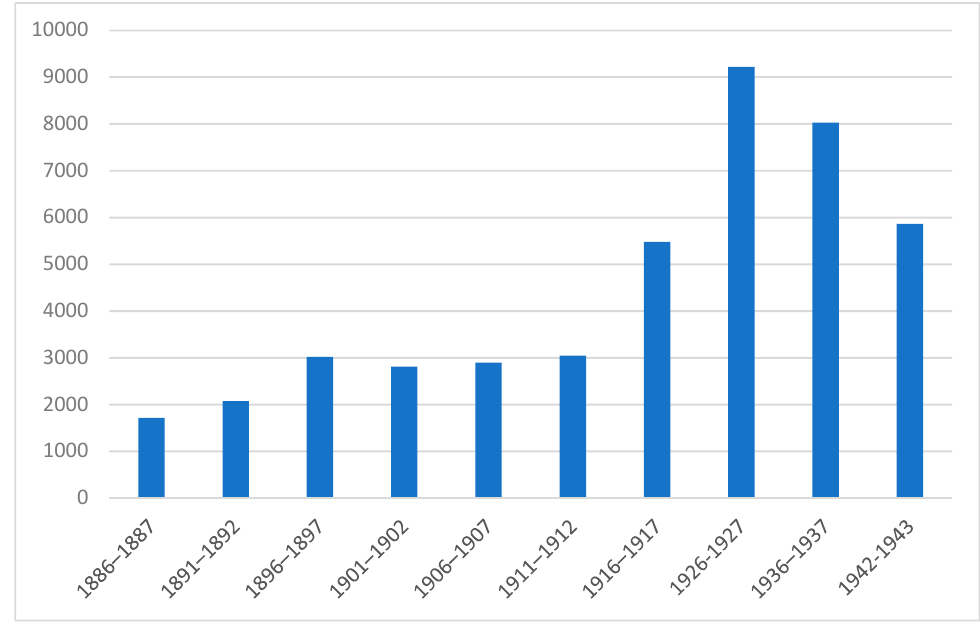
Figure 3. Total of students enrolled in law studies in Indian universities, 1886–1942. This figure presents the total number of students enrolling in law studies in one of the Indian universities from 1886 to 1942. It gives figures for some academic years within this timespan.